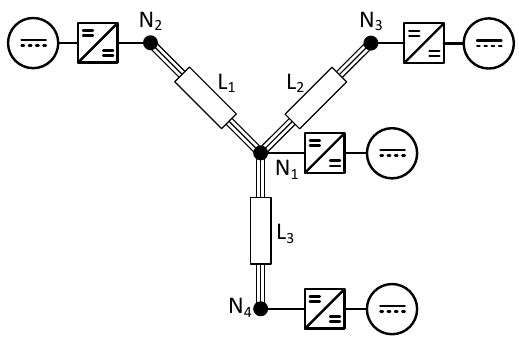
Figure 7. Example of a DC distribution grid with four nodes and three lines in a star